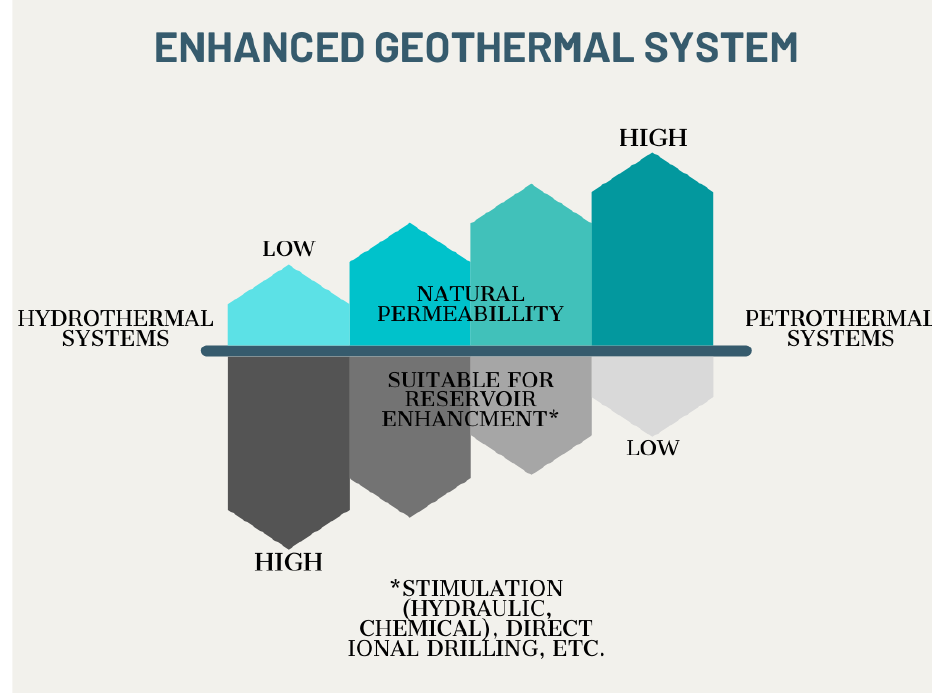
Figure 2. Hydrothermal versus petrothermal systems (modified after [24]).